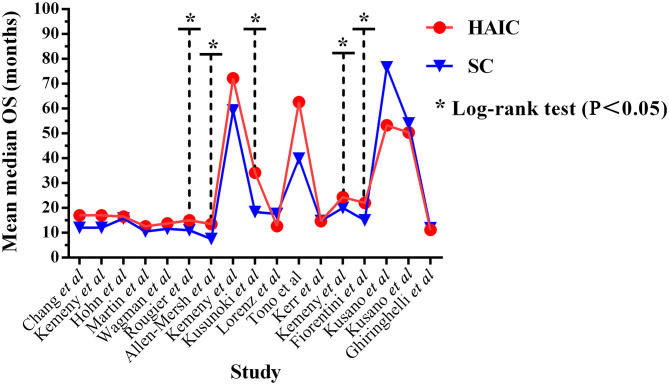
Mean median overall survival time.